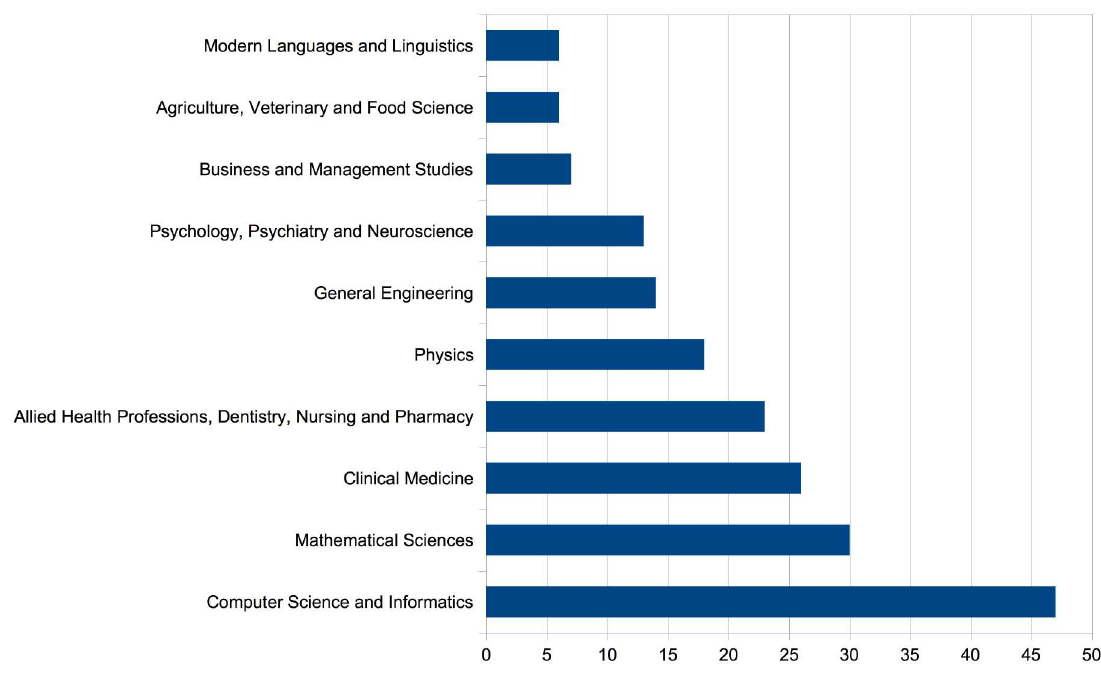
Fig 3. Breakdown of Institution Submissions found to have links to paper in the ECNs per Unit of Assessment. We show here the 10 UoAs with the largest number of ECN-linked submissionsonly.